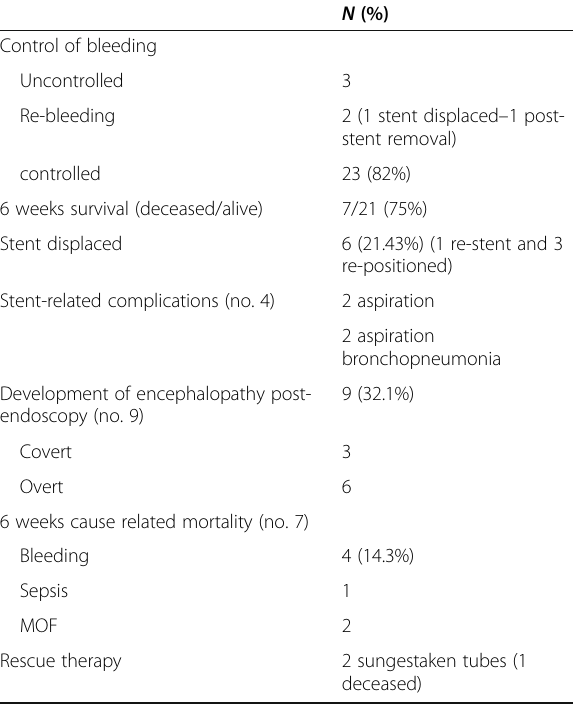
Table 2 Outcome